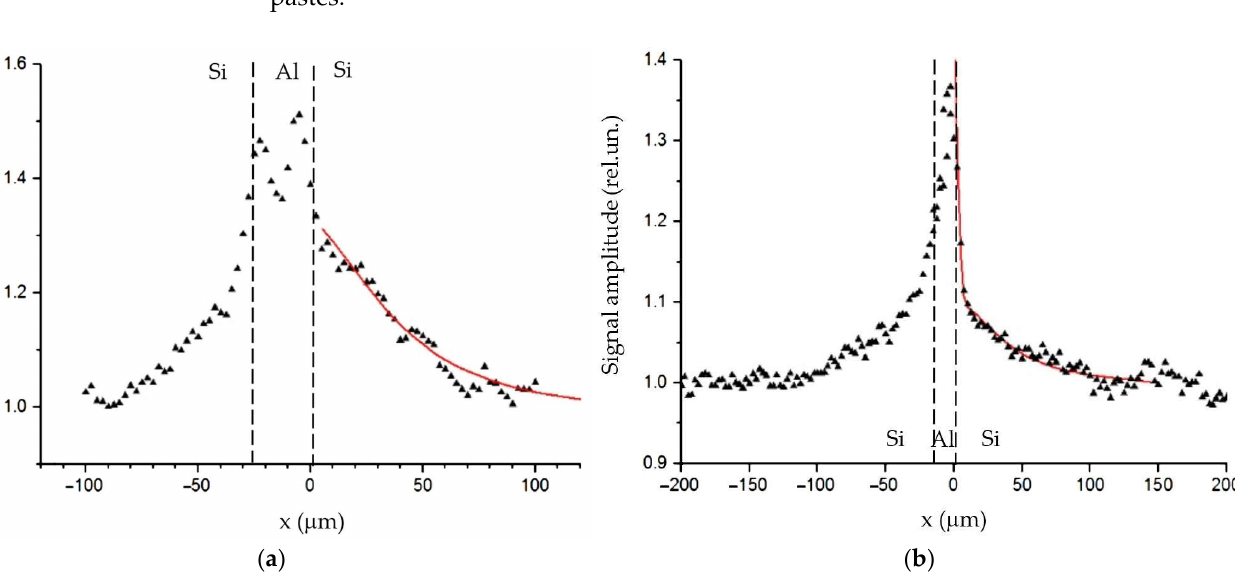
Figure 7. Amplitude of the PBD signal across a solder joint of two silicon diodes: ( a ) silicon wafers with ground surfaces; ( b ) silicon wafers with polished surfaces. Triangles are for experimental data. Red curves are fitting. Dash lines are joint boundaries. Adapted with permission from [70]. Copyright (2011), Pleiades Publishing, Inc.